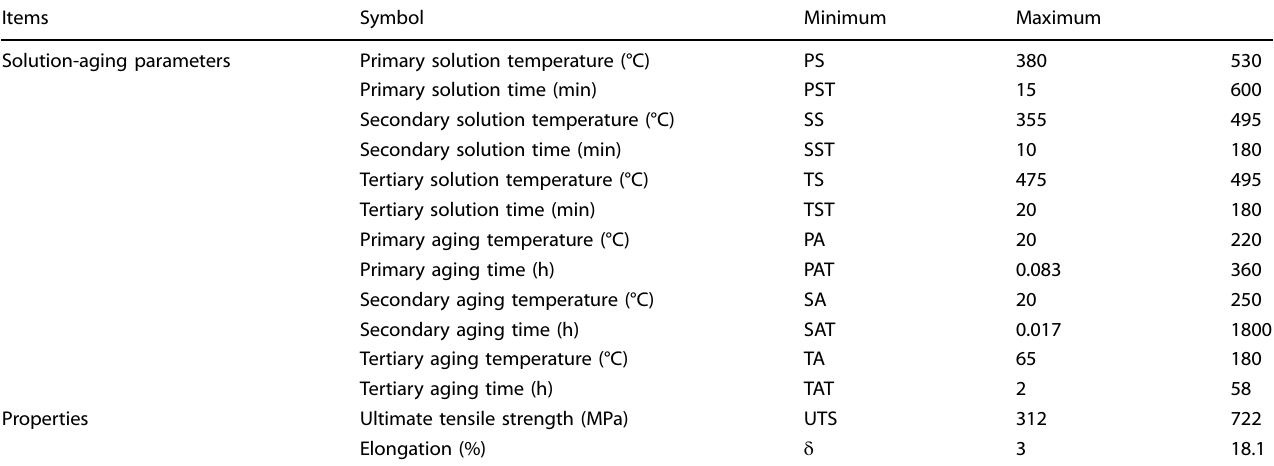
Table 4. The numerical ranges of solution-aging parameters and properties in the